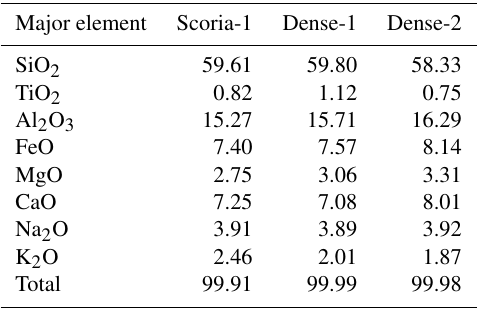
Table 5. Major element bulk rock geochemical XRF analysis. Major